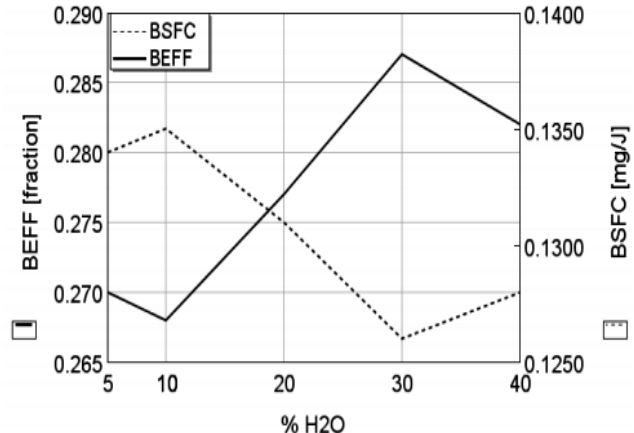
Figure 6. Effect of increased water content in ethanol on the brake thermal efficiency and brake fuel consumption. Reprinted with permission from Reference [78]. Copyright (2013) SAE specific fuel consumption. Reprinted with permission from Ref. [78]. Copyright (2013) SAE International.